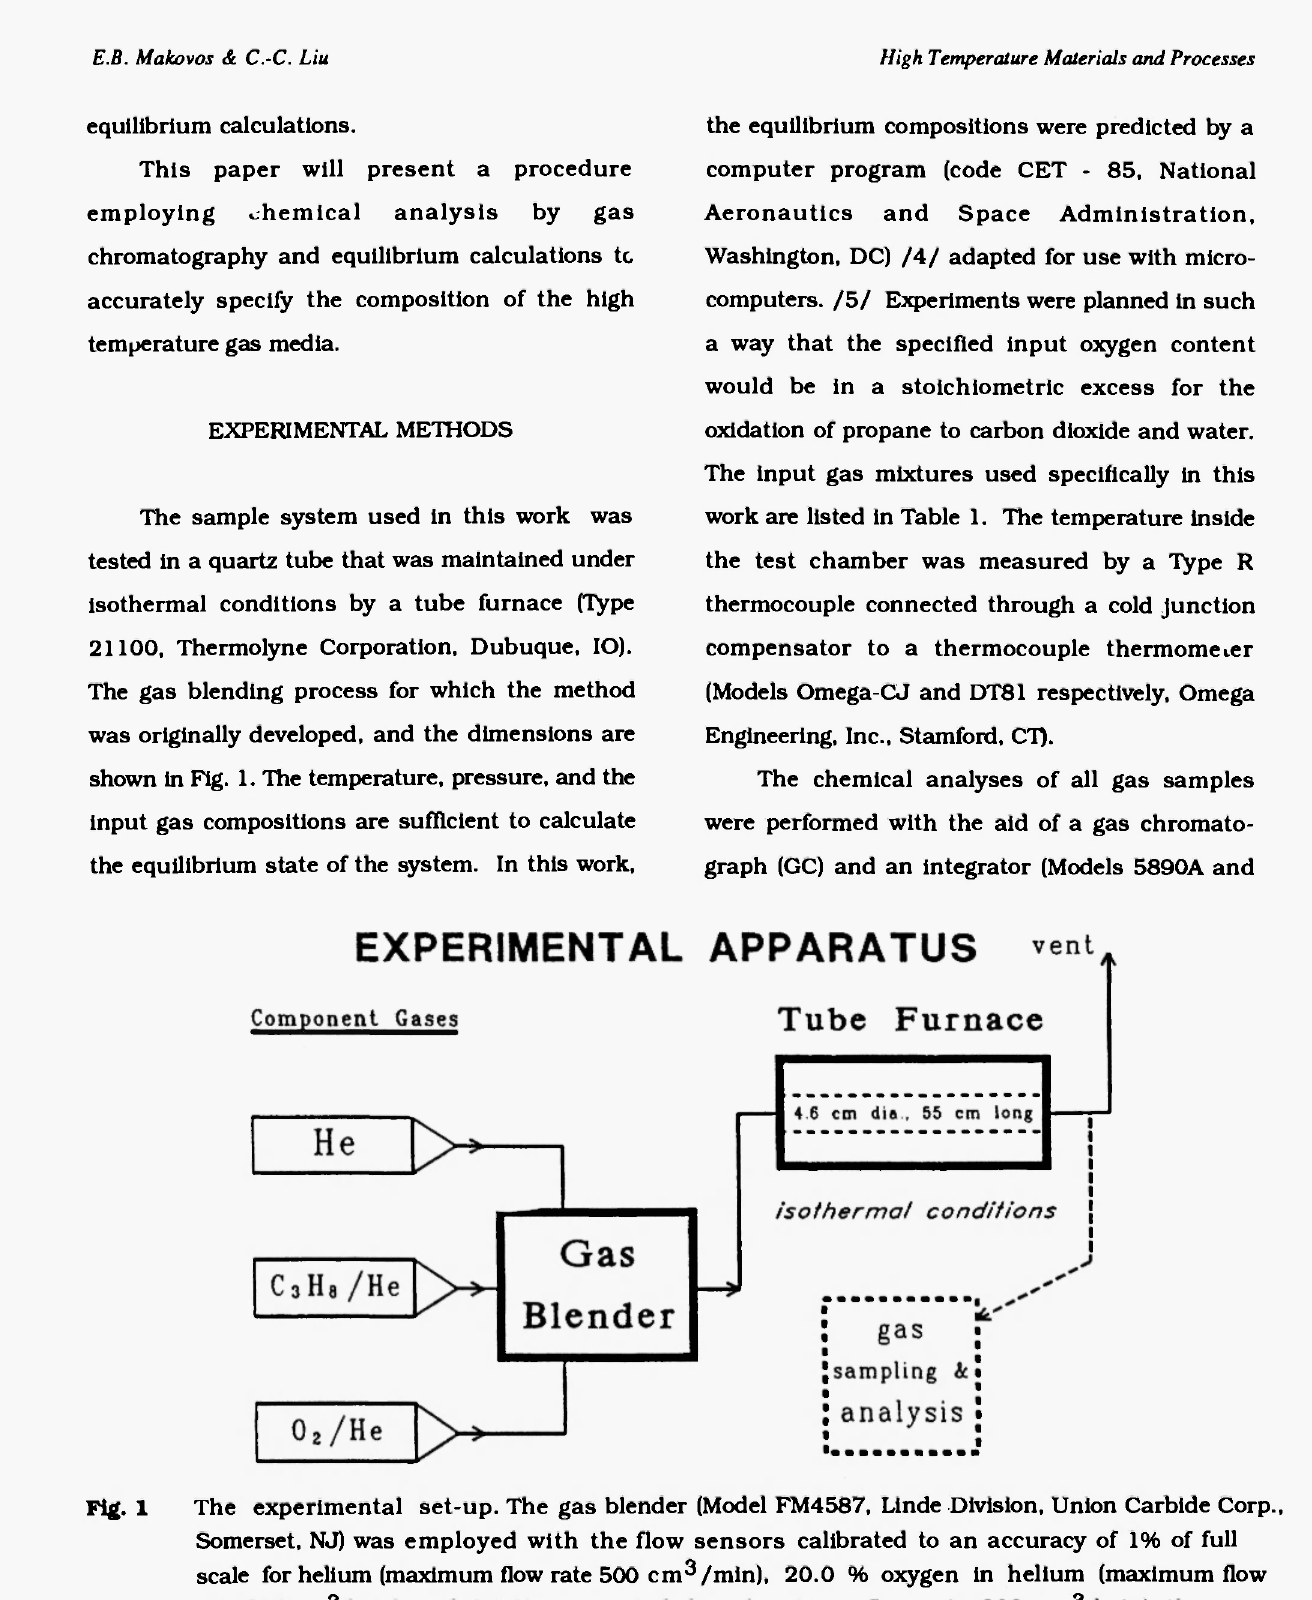
Fig. 1 The experimental set-up. The gas blender (Model FM4587, Linde Division, Union Carbide Corp., Somerset, NJ) was employed with the flow sensors calibrated to an accuracy of 1% of full scale for helium (maximum flow rate 500 cm 3 /min), 20.0 % oxygen in helium (maximum flow rate 200 cm 3 /min), and 1.2 % propane in helium (maximum flow rate 200 cm 3 /min), the gases were research quality supplied by Air Products and Chemicals, Inc., Tamaqua,